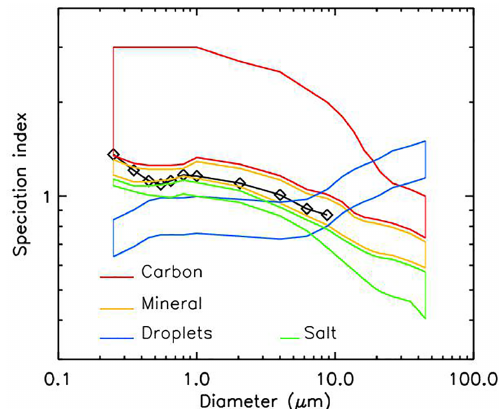
Figure 2. “Speciation zones” obtained in laboratory for several types of particles (colour lines) and an example of LOAC speciation index obtained during ambient air measurements inside a Saharan dust plume at an altitude of 3.1km (18 June 2013, 18:15UT) above Minorca, Spain